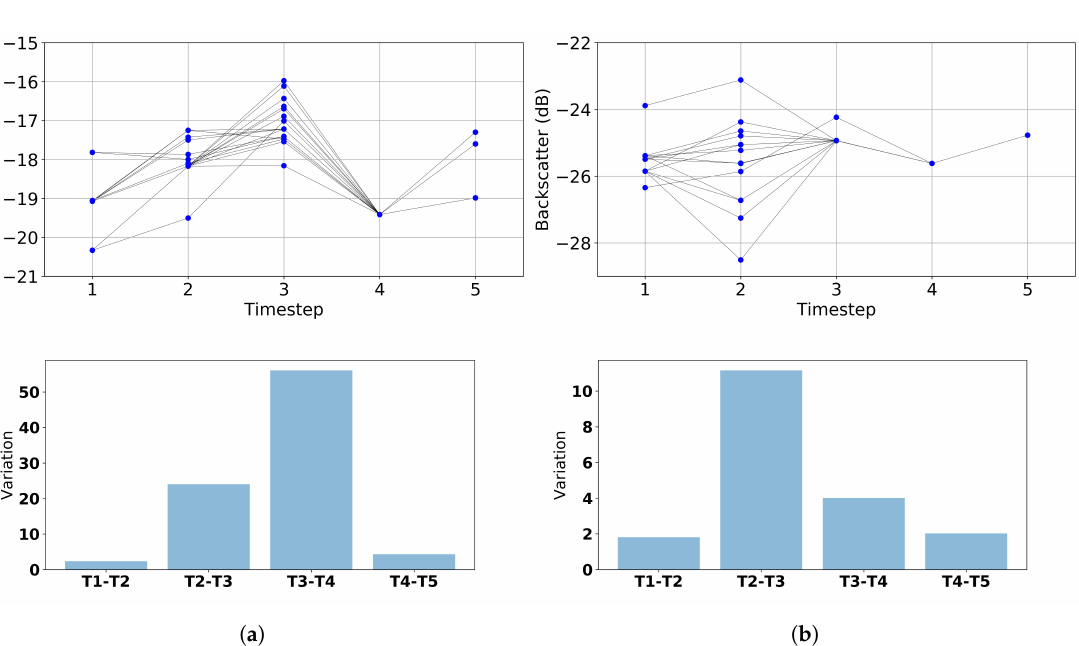
Figure 12. Bridge over Albert Canal in the static zone.